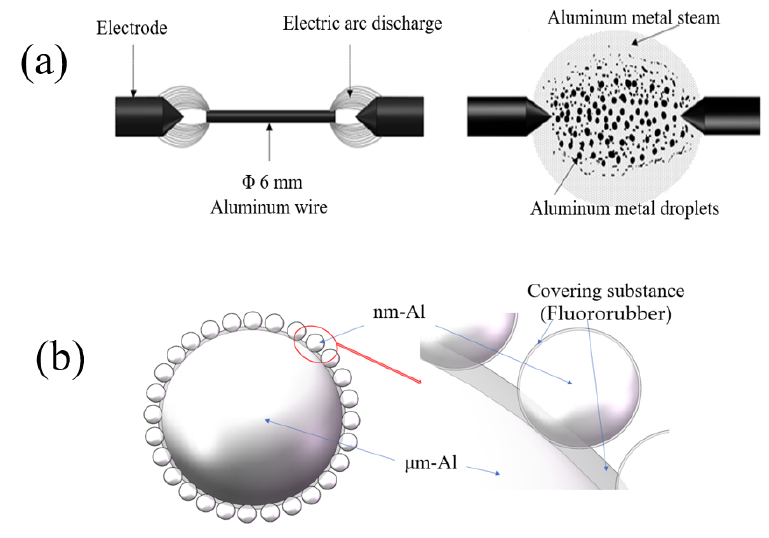
Figure 1. Electric explosion schematic ( a ) and target structure diagram ( b ).